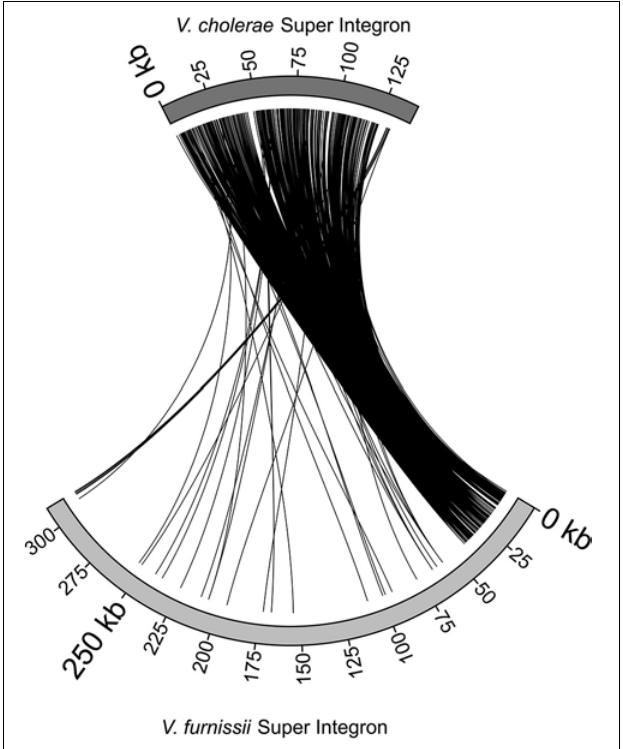
FIGURE 3 | Comparison of the Super Integrons of V. cholerae O1 biovar El Tor Nr. 16961 and V. furnissii